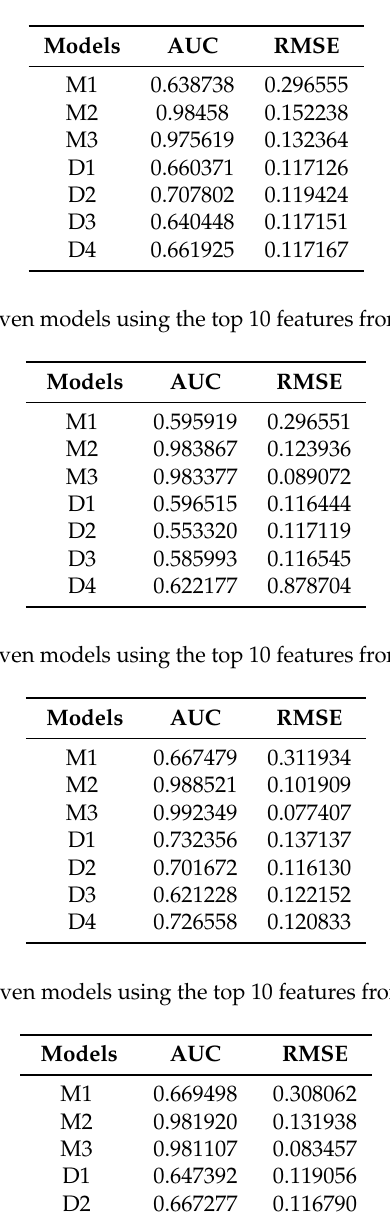
Table 5. Performance for the seven models using the top 10 features from model M1 on the test dataset.